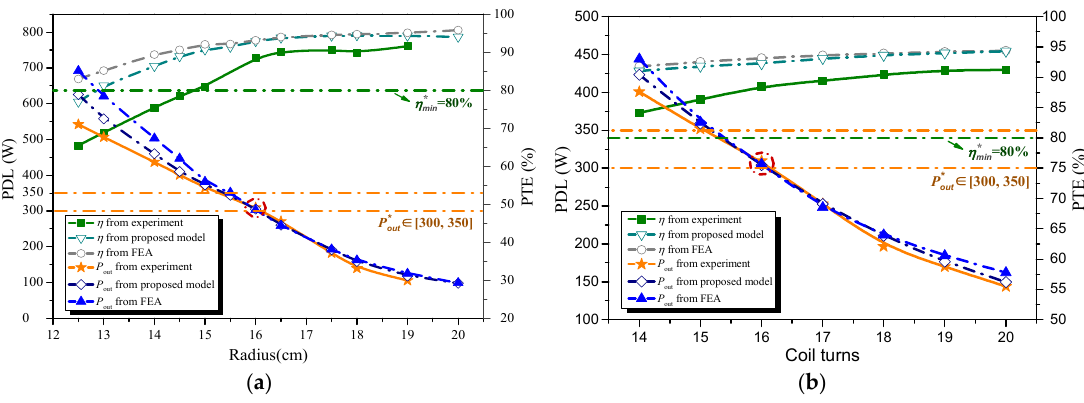
Figure 10. Experimental results of PTE and PDL versus coil parameters: ( a ) radius; ( b ) coil turns.